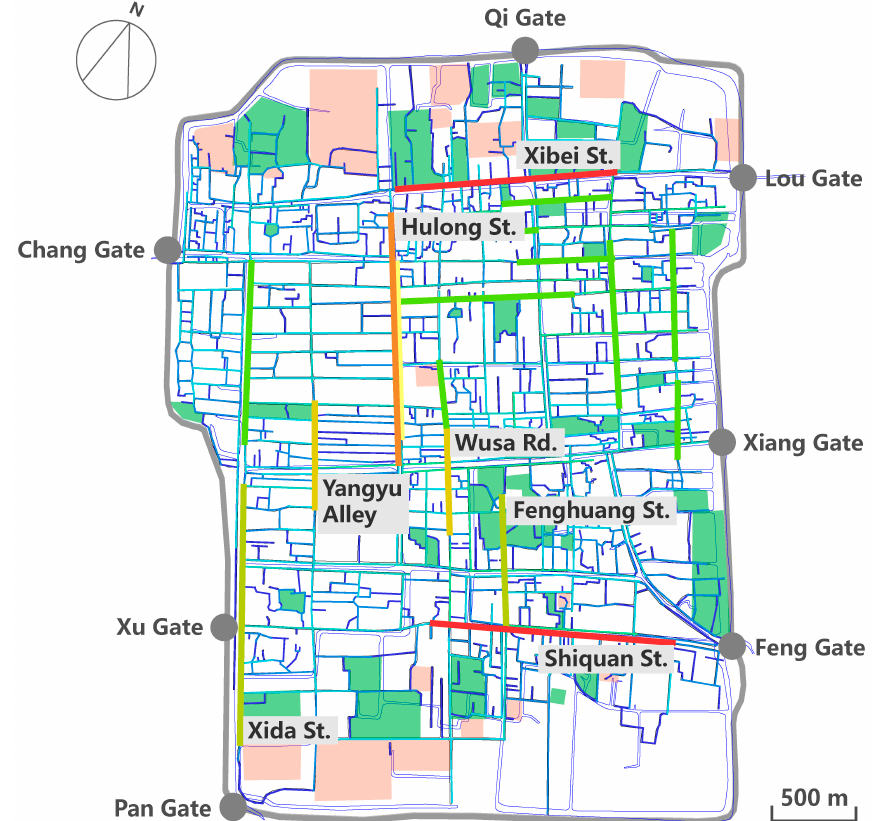
Figure 3. Street axis model analysis results. Streets marked in red are the most integrated streets, and those marked in dark blue are the least integrated streets. Streets with a higher degree of integration have more intersections with other streets, and streets with a lower degree of integration have fewer intersections with other